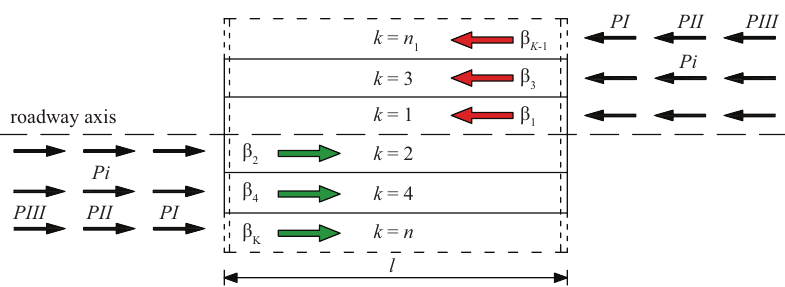
roadway axis Figure 10. Diagram of the bridge with span length l and k = n traffic lanes